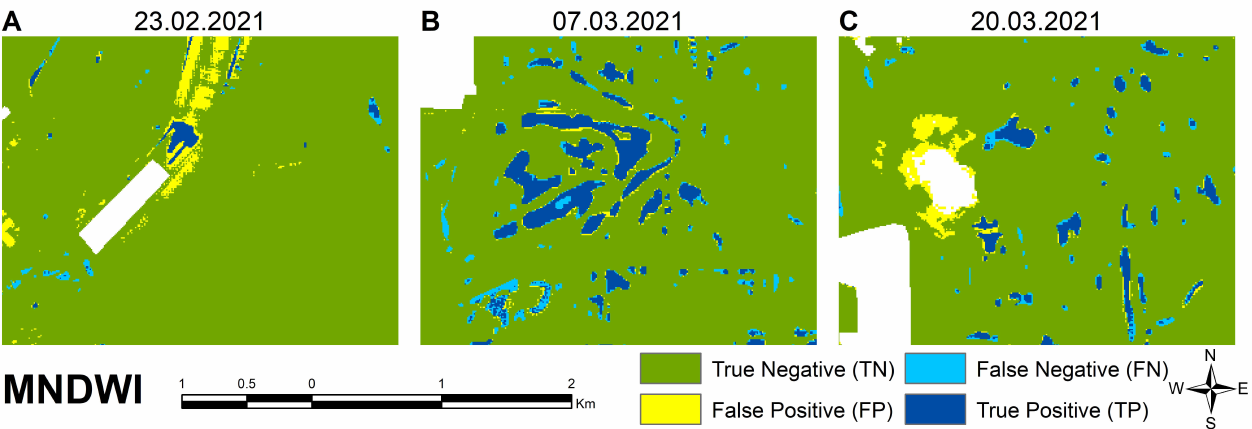
Figure 11. Examples of MNDWI model classification errors at different times, including ( A ): Omis ‐ sion in reference map 23 February 2021; ( B ): shallow water 7 March 2021; and ( C ): errors near the cloud and shadow mask 20 March 2021.